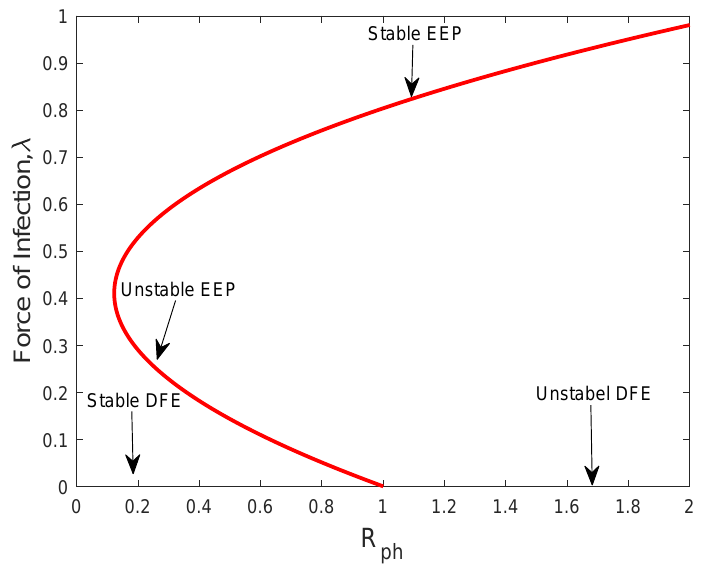
Figure 2. The bifurcation diagram of force of infection against R ph which illustrates a backward bifurcation for the system model